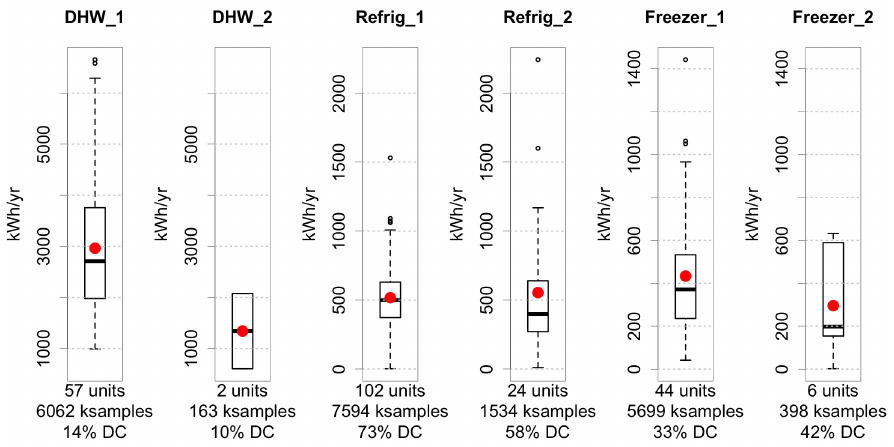
Figure 3. Boxplots of TCL appliance annual energy use. Mean values are shown in red. Values below each plot indicate the number of appliances, sample observations, and average duty cycle from Q2 2012–Q1 2013 inclusive. Note the wide range of diversity, particularly among refrigerators and